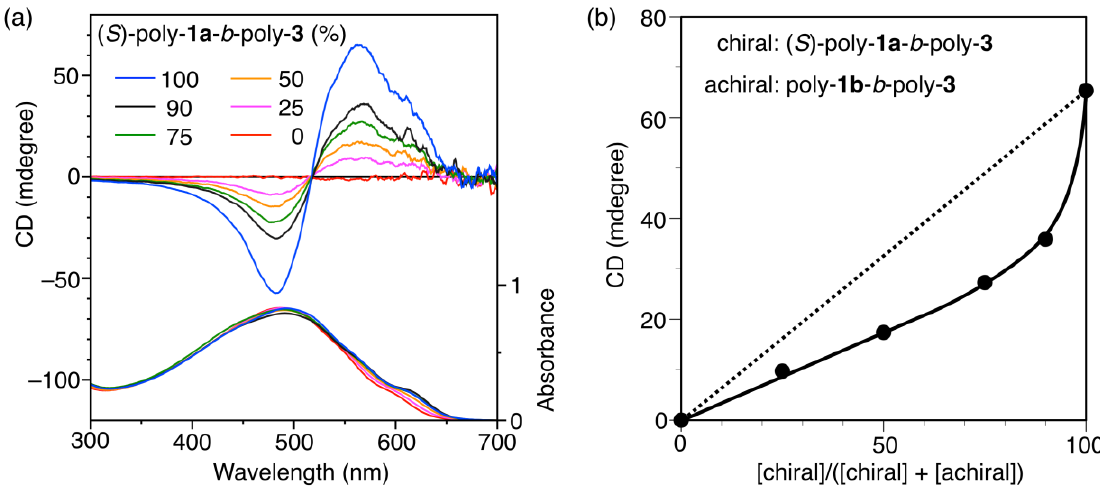
Figure 3. ( a ) CD and absorption spectra of aggregates consisting of ( S )-poly- 1a - b -poly- 3 and poly- 1b - b -poly- 3 ; ( b ) Plots of CD intensity at around 565 nm for aggregates consisting of ( S )-poly- 1a - b -poly- 3 and poly- 1b - b -poly- 3 in THF/H 2 O (9:1, v/v ) at rt.